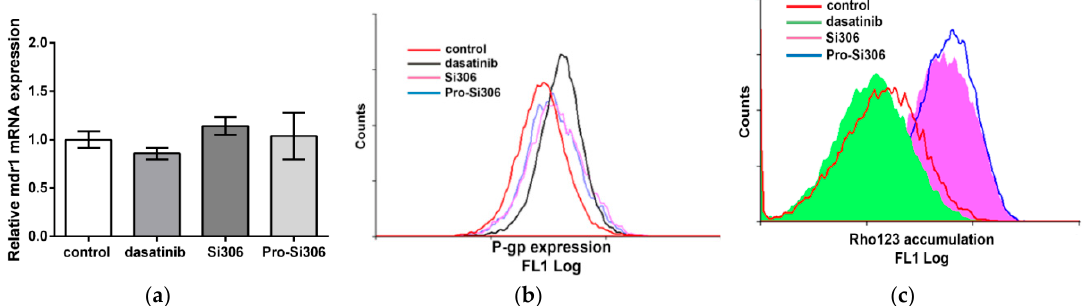
Figure 2. The effects of c-Src inhibitors on P-gp expression and function. ( a ) qRT-PCR analysis of mRNA mdr1 expression (mean ± S.D., n = 3) and ( b ) flow-cytometric profiles of P-gp expression in U87-TxR cells after 72 h treatment with 5 µM Si306, pro-Si306 and dasatinib. ( c ) Flow-cytometric profile of Rho 123 accumulation after 30 min treatment with 5 µM Si306, pro-Si306 and dasatinib in U87-TxR cells.